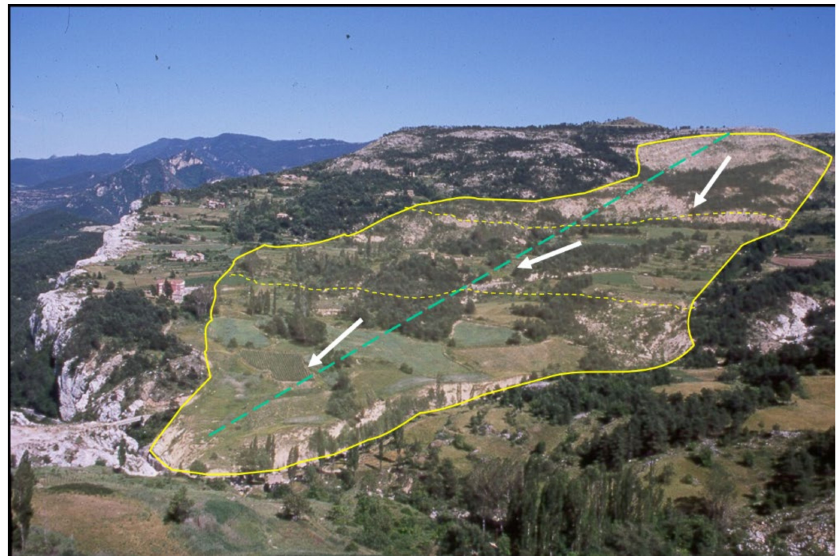
Figure 2. General view of the Vallcebre landslide from W. The unstable area (yellow contour) is about 0.8 km 2 , has an average slope of only 17 ◦ (green line), and is sliding as a translational slide. The white arrows are the average slide directions of the upper, middle and lower units, which are separated by scarp zones (dashed yellow